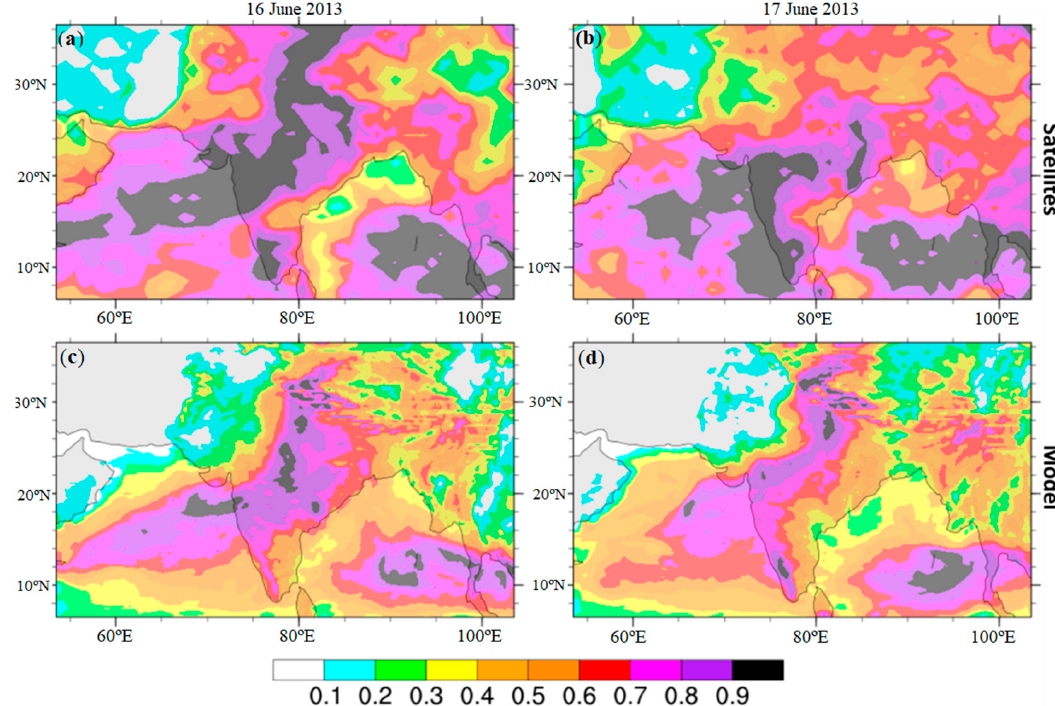
Figure 5. Average cloud fraction on 16 and 17 June ( a ) and ( b ) the MODIS satellites (Aqua and Terra combined) ( c ) and ( d ) model, respectively.